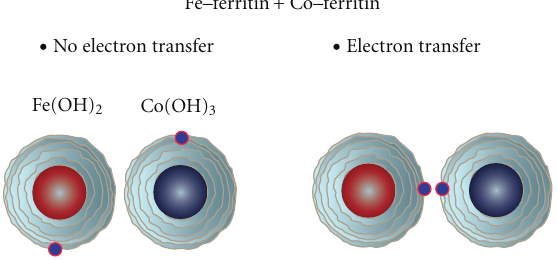
Figure 7: Electron transfer through the ferritin protein shell. The blue dot in the cut-away view of the protein shells containing Fe(OH) 2 (pink) and Co(OH) 3 (purple) mineral cores represents the electron transfer centers within the ferritin shell. The model on the left indicates that the two electron transfer centers are not in contact and do not provide a pathway for electron exchange. The model on the right shows the two redox centers aligned and capable of exchanging electrons from the two mineral cores. The models only show one of several possible electron transfer centers present in each ferritin protein